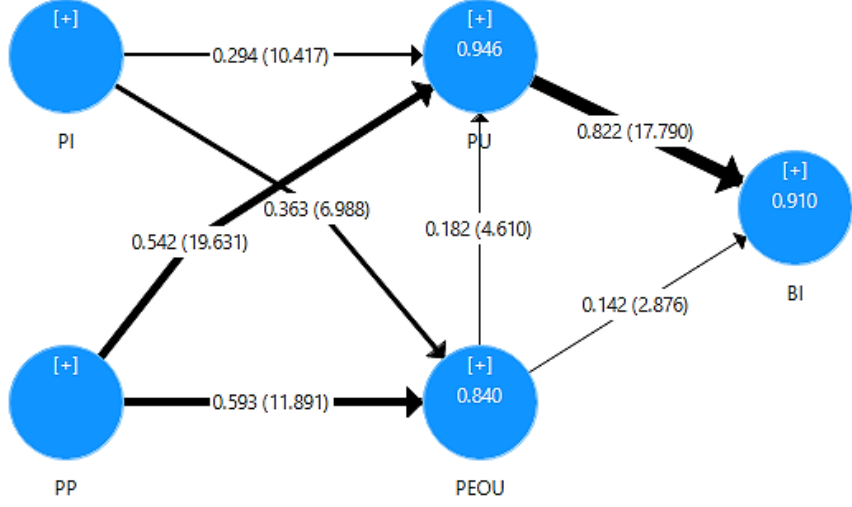
Figure 8. Structural model’s results.